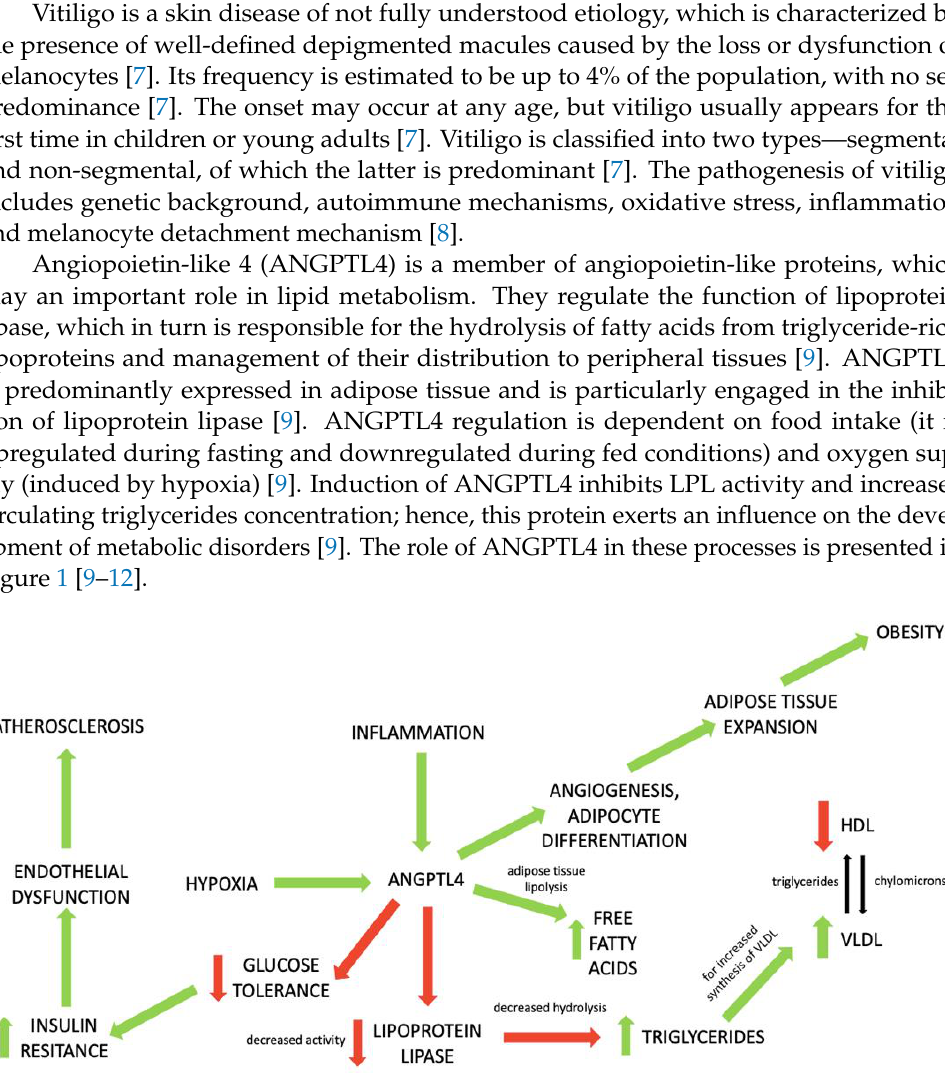
Figure 1. The role of ANGPTL4 in the development of metabolic disorders. Green arrows mean stimulation; red arrows mean inhibition of process.